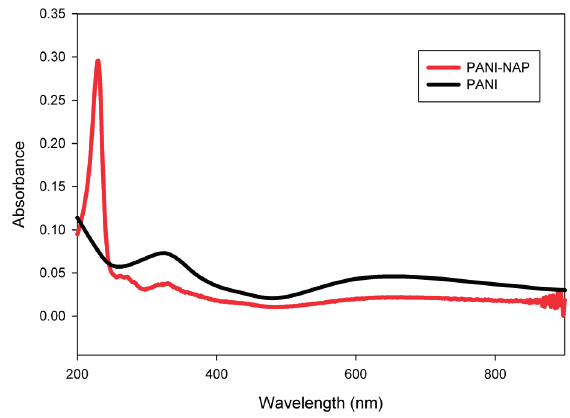
Figure 1. Absorption spectra of PANI and PANI-Nap.